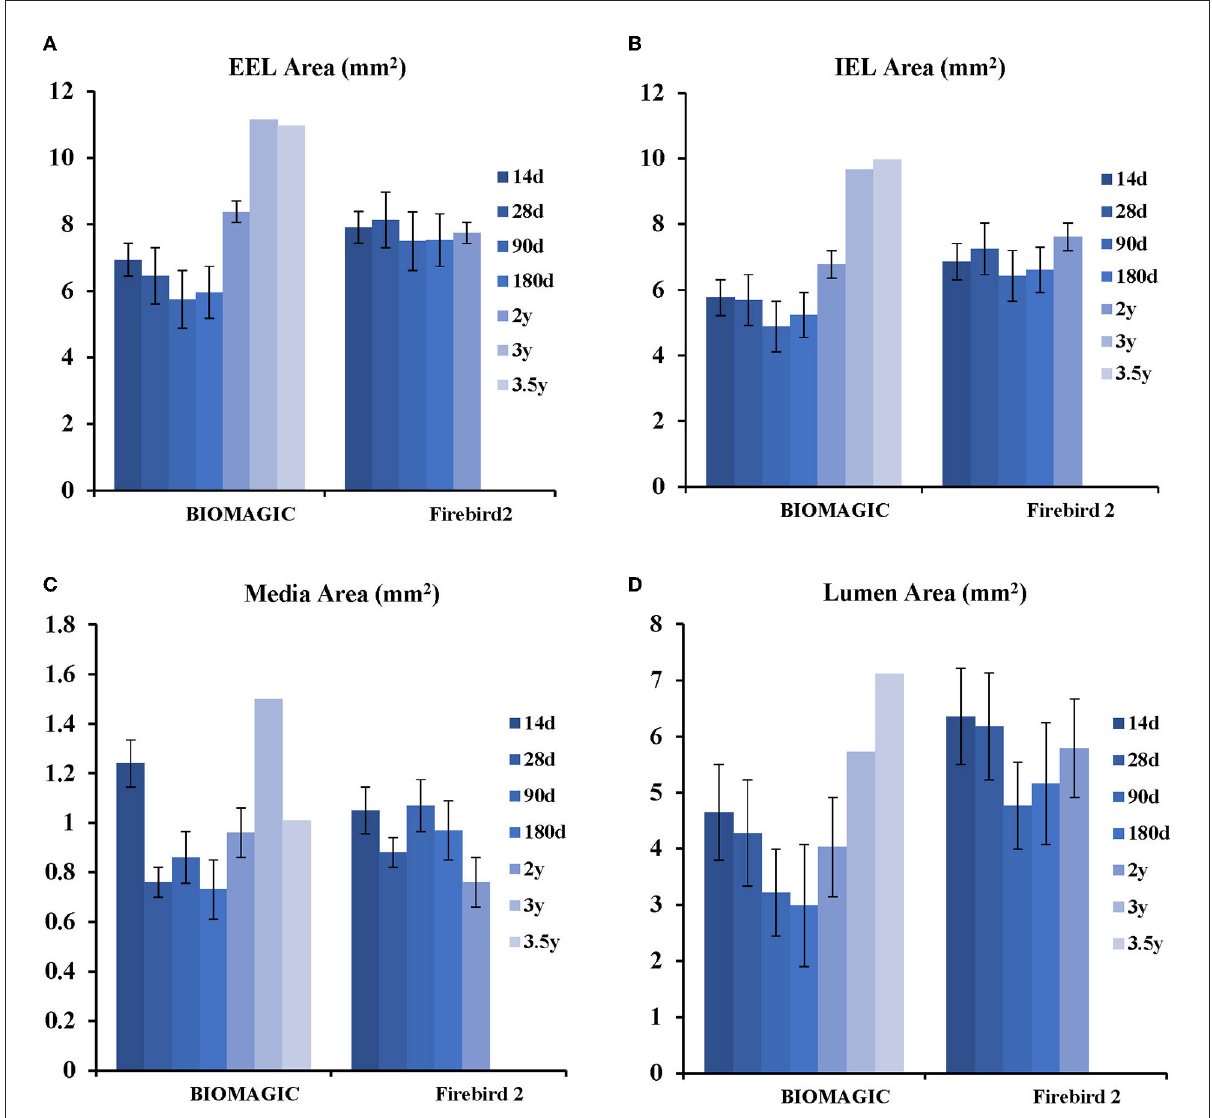
FIGURE3 Histological analysis of Biomagic BVS and Firebird2 DES (A) comparison curve of EEL. (B) Comparison curve of IEL. (C) Comparison curve of media area. (D) Comparison curve of lumen